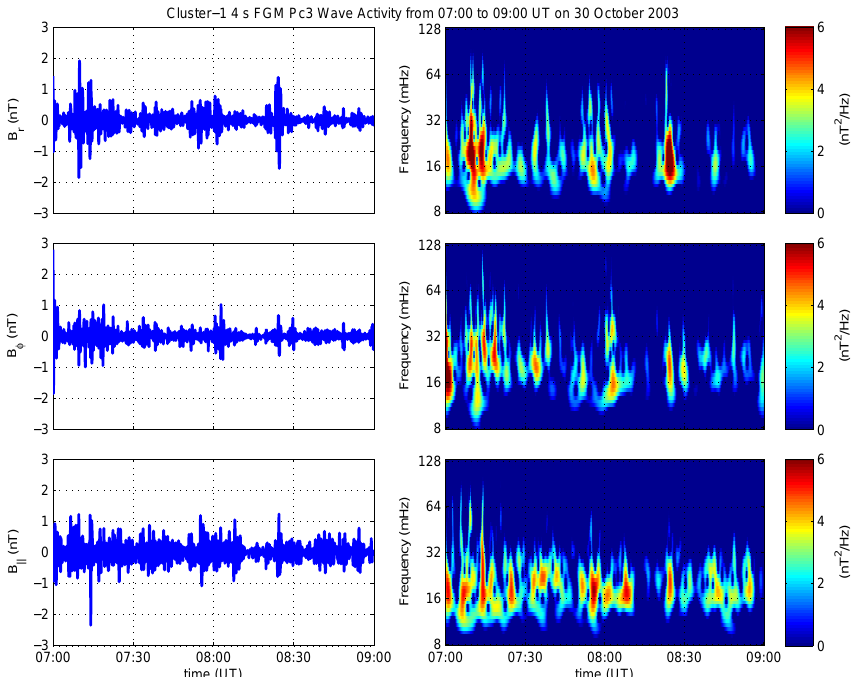
Fig. 7. Event 1: 07:00–09:00UT, 30 October 2003. The Cluster-1 Pc3 (8–128mHz) activity. Left column: From top to bottom are shown the time series of the poloidal, toroidal and compressional components, respectively, of the magnetic field, calculating from the 4s FGM data after applying a 16mHz high-pass filter. Right column: From top to bottom are shown the corresponding wavelet power